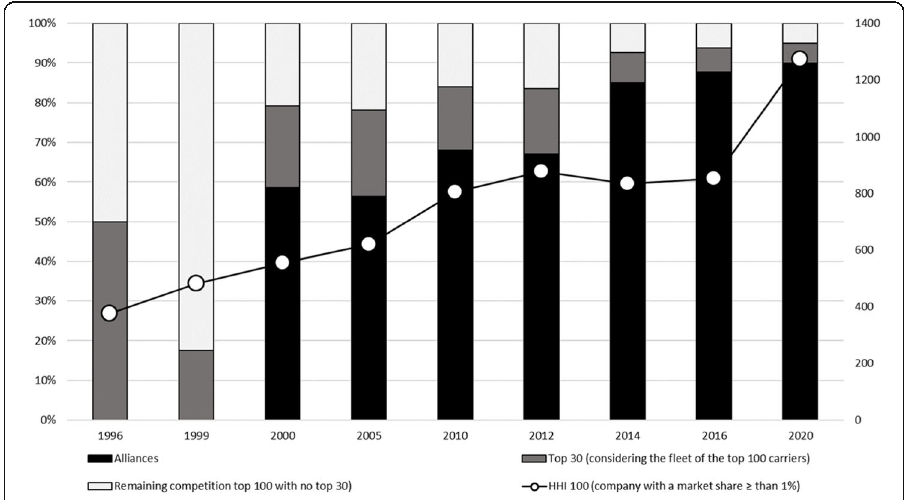
Fig. 4 Concentration in the shipping industry. Source: Eliana P. Barleta and Ricardo J Sanchez,